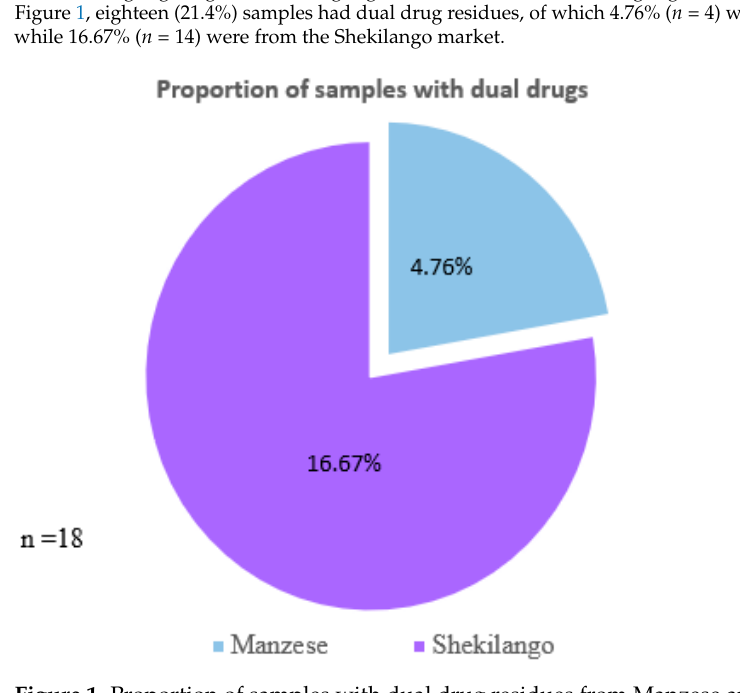
Figure 1. Proportion of samples with dual drug residues from Manzese and Shekilango markets.